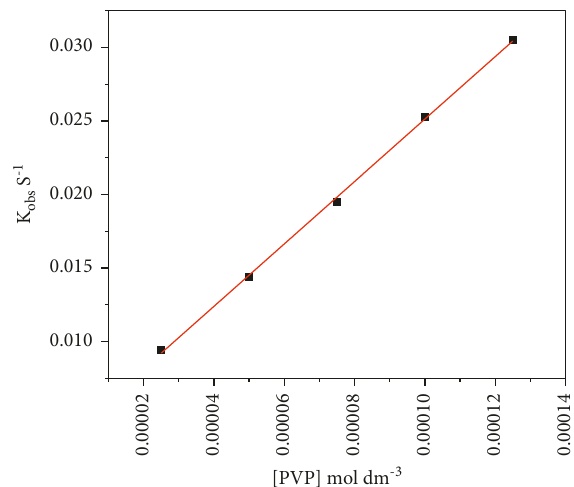
Figure 6: k obs versus [PVP] at the following reaction conditions: [Ce (IV)] � 0.0030moldm − 3 , [Maltose] � 0.030moldm − 3 , and [H 2 SO 4 ] � 0.40 moldm − 3 at